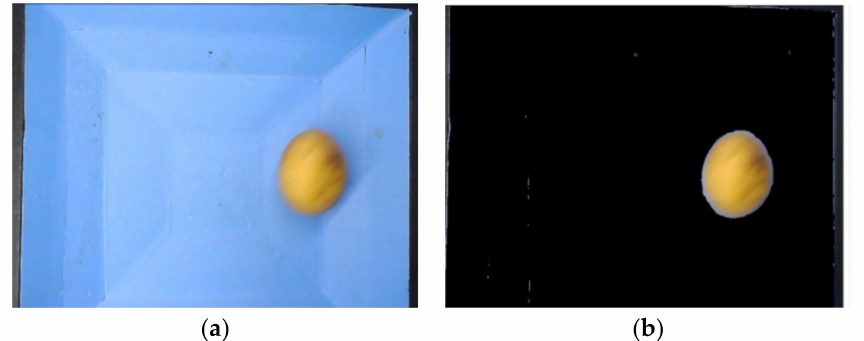
Figure 4. Processing effects before and after color space separation and filtering. The sample is an image of a rolling potato taken with a 2-megapixel camera: ( a ) Pre-processing effect of color space separation and filtering. ( b ) Post-processing effect of color space separation and filtering; in the black background, the material entity is the main part, with some noise occurring in the background. The noise appears in the form of tiny white patches in the